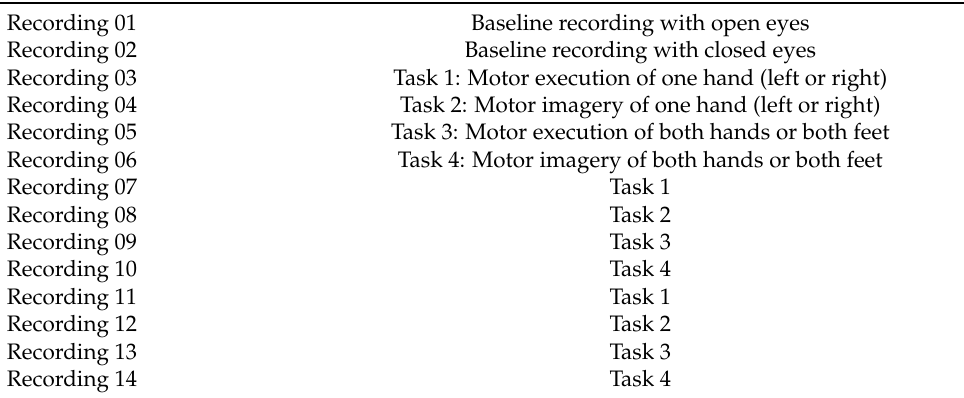
Task 2: Motor imagery of one hand (left or right) Task 3: Motor execution of both hands or both